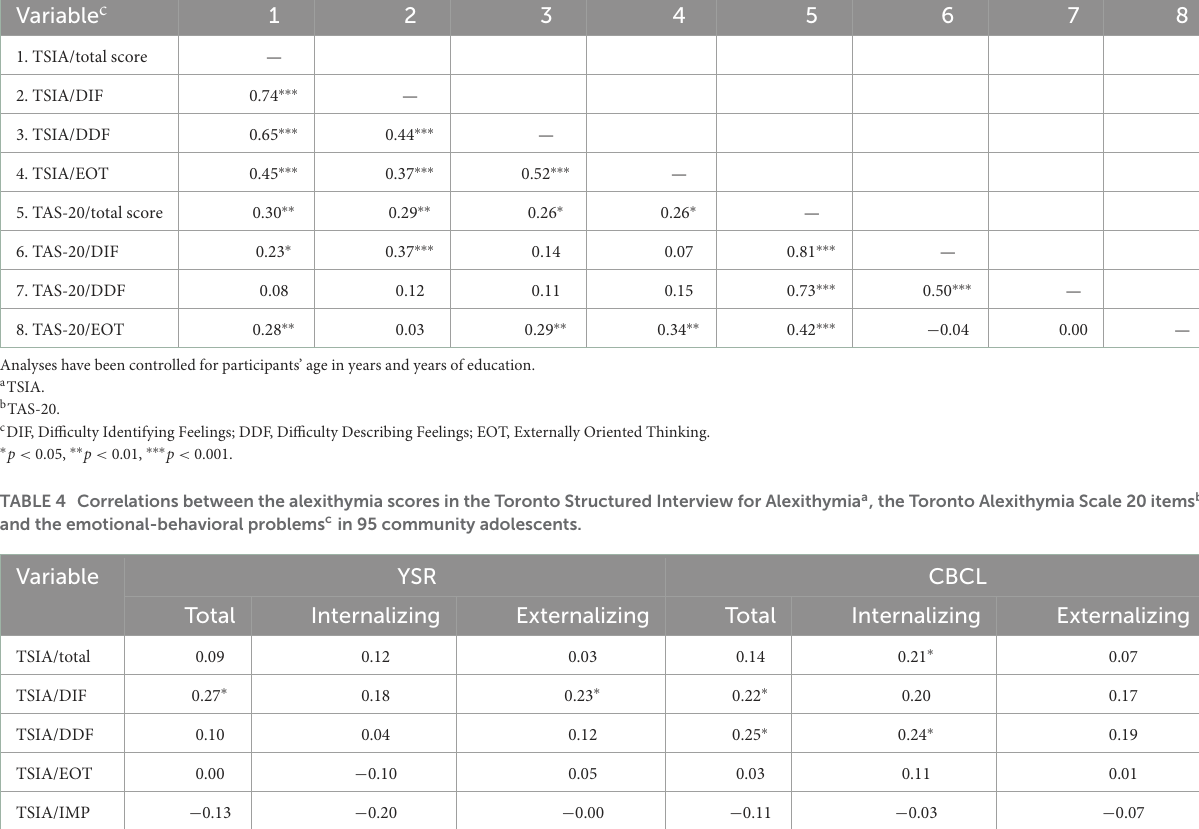
TABLE 3 Correlations between the Toronto Structured Interview for Alexithymia a and the Toronto Alexithymia Scale 20 items b in 95 non-clinical adolescents. Variable c